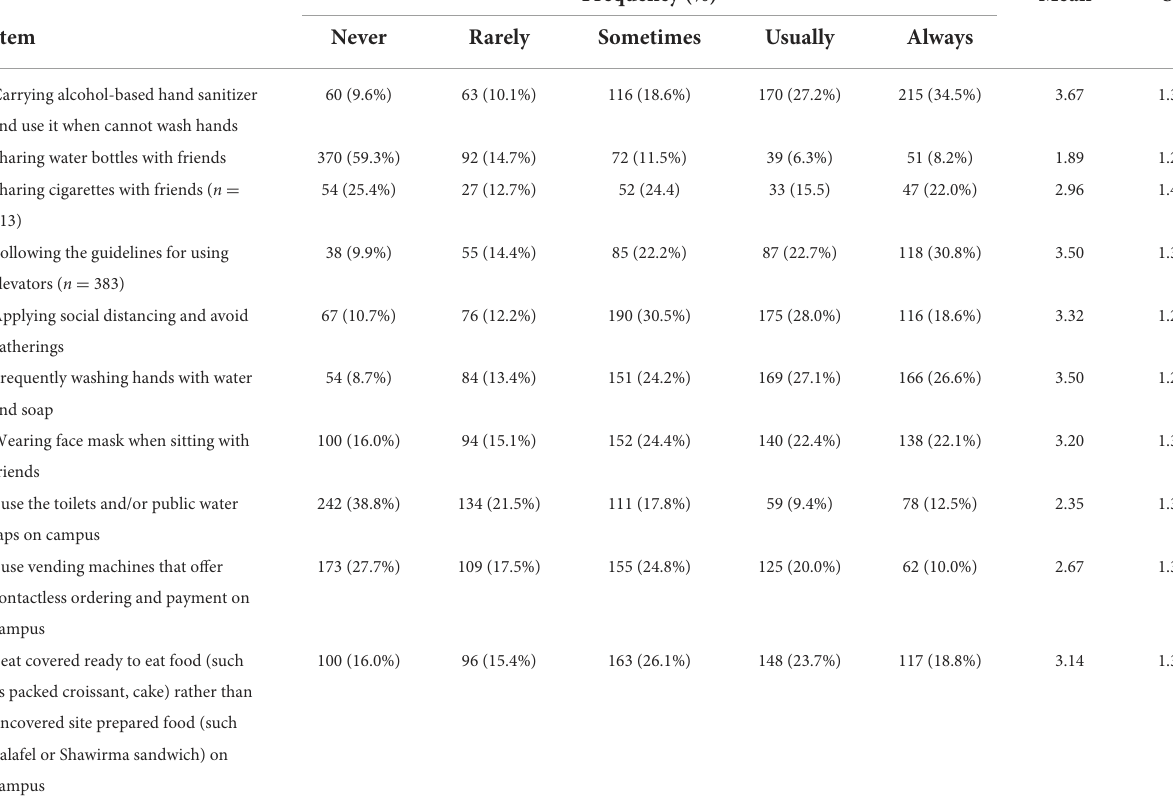
TABLE 4 Back on campus-level of protective behaviors. Frequency (%) Mean* SD Never